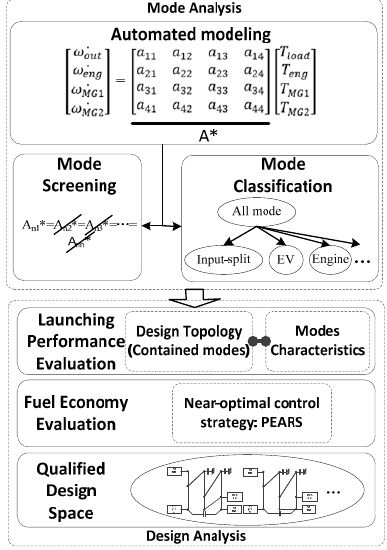
Figure 2. The proposed process for exhaustive topology search. PEARS: power ‐ weighted efficiency analysis for rapid sizing.